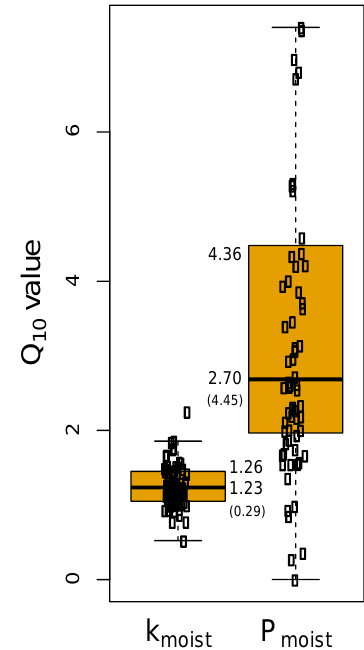
Figure 6. The estimated temperature sensitivity ( Q 10 ) of COS pro- duction ( P moist ) and hydrolysis rate ( k moist ) across 27 sites in Eu- rope and Israel. Each point represents the estimated parameter for each of the three replicated microcosms incubated at two tempera- tures from all sites. The box indicates the lower, median and upper quartile values, the whiskers show the range of variation in the dif- ference and display the mean (SD) and median value for the Q 10